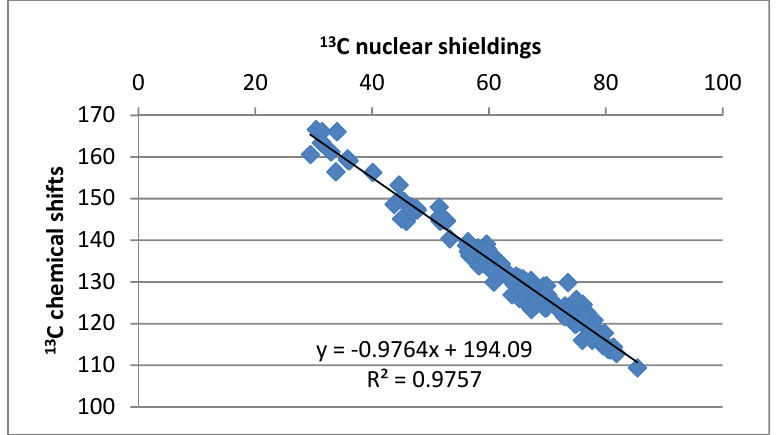
Figure 5. Plot of 13 C-NMR chemical shifts vs. calculated 13 C nuclear shieldings.